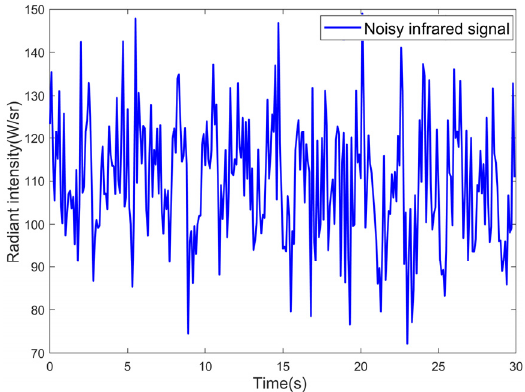
Figure 7. The noisy radiation intensity signal.